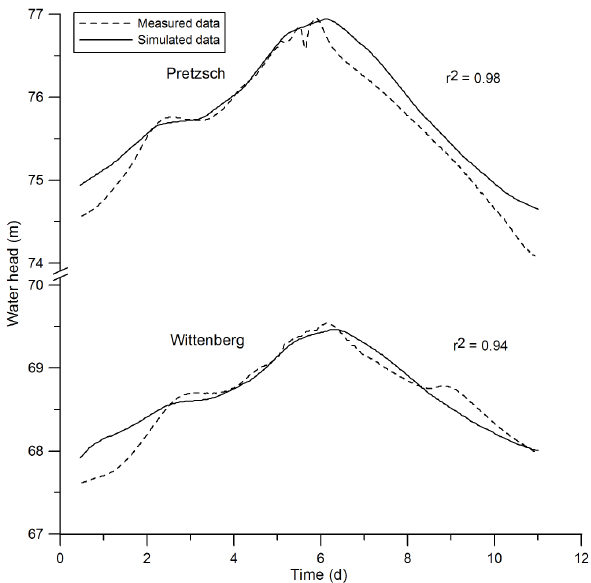
Fig. 7. Simulated and gage recordings of the water level at Pretzsch and Wittbenberg during the January 2003 flood event.